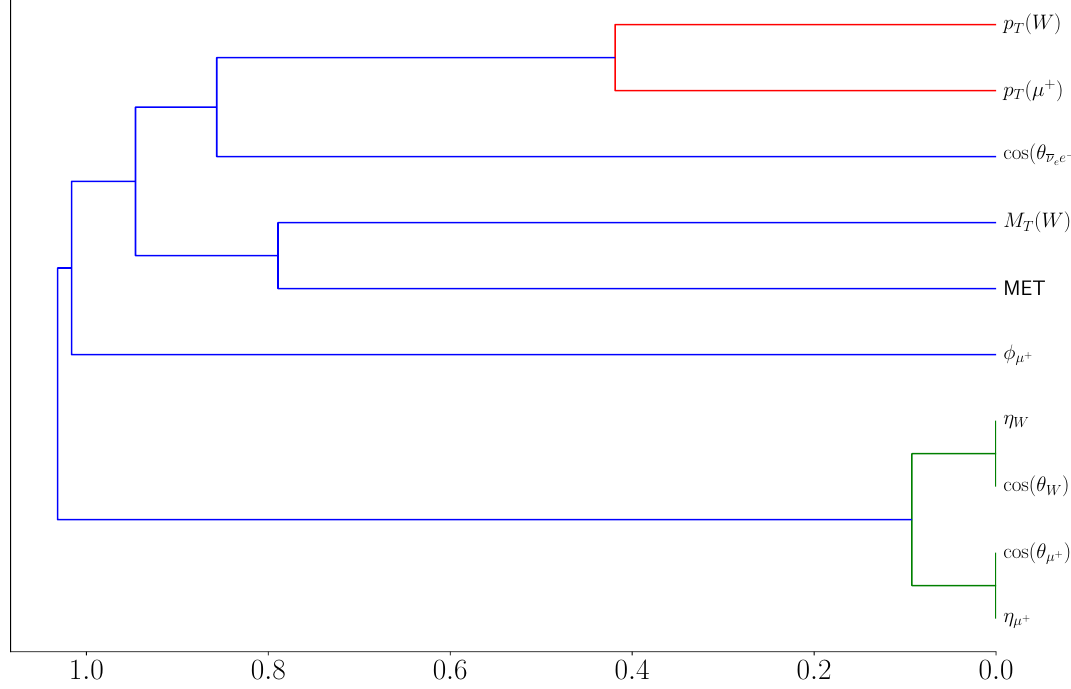
Figure 26. Hierarchical clustering of the various kinematic/angular variables utilized by the neural network model for a light VLL of 200 GeV and VLBSM topology signal, under the Asimov